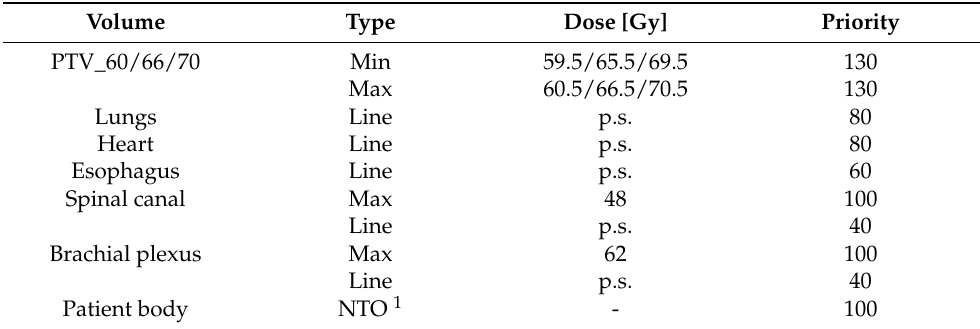
Table 3. Applied Eclipse objective template. p.s. = patient specific, defined based on Erasmus- iCycle